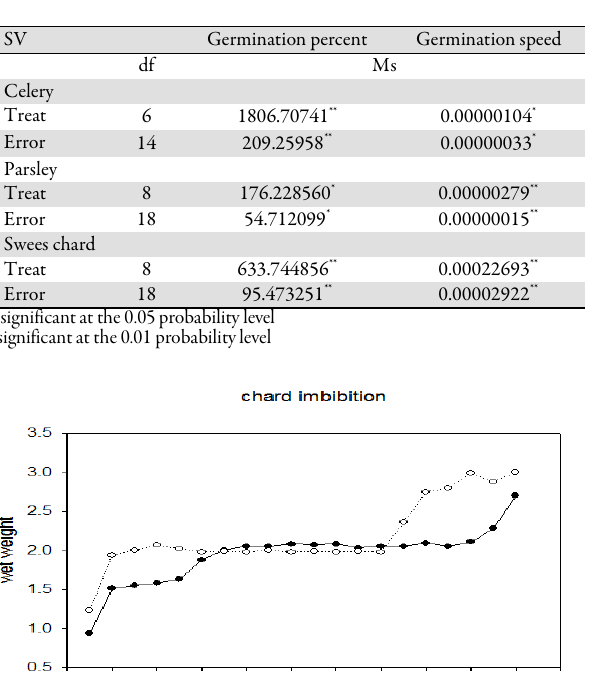
Table 2. Analysis of variance for speed and percent of germination